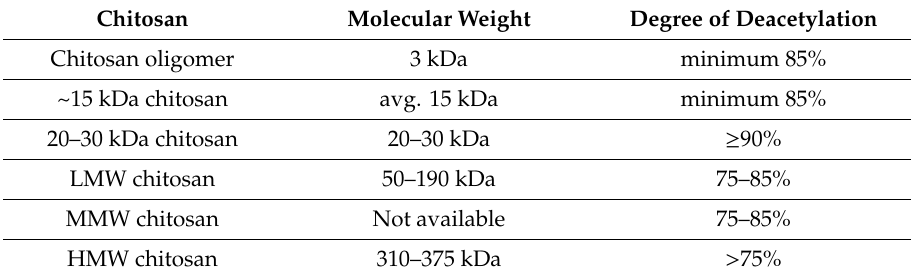
Table 6. Chitosans used in this study. LMW, low molecular weight; MMW, medium MW; HMW, high